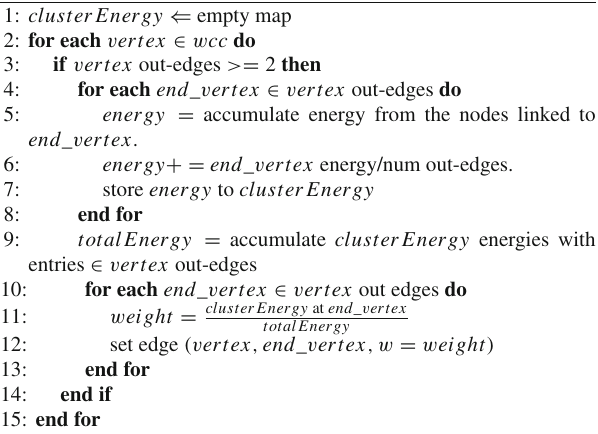
Algorithm 3 Calculate overlap